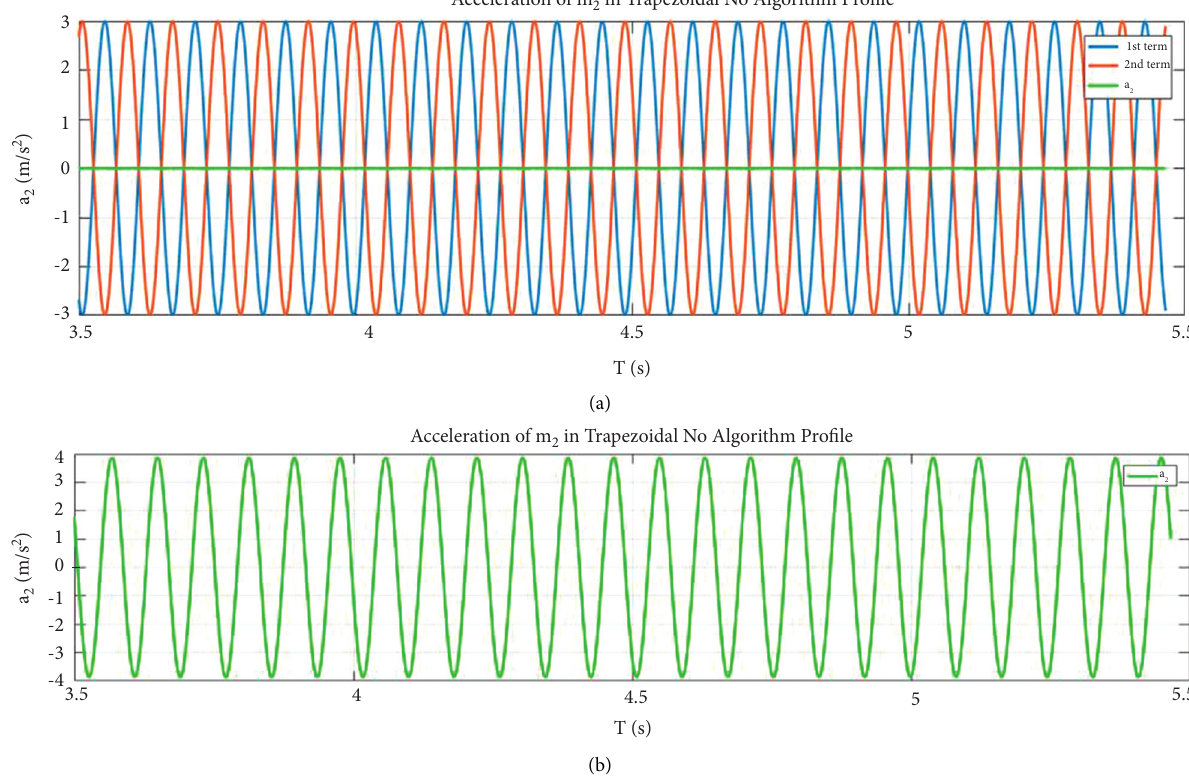
2 (a) and its enlarged plot (b) with the trapezoidal strategy. Blue:1